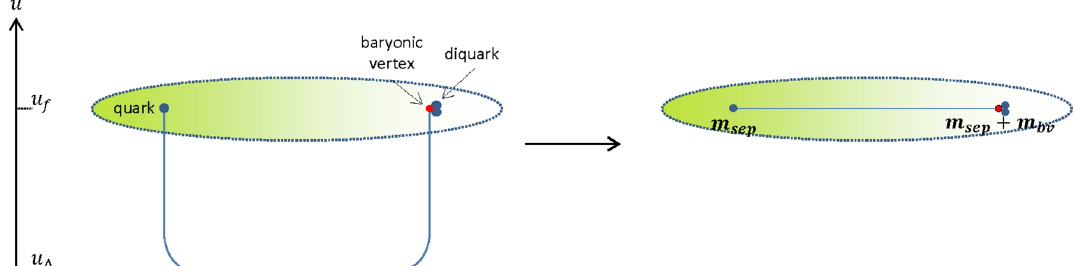
model are depicted in Fig. 2. We emphasize that